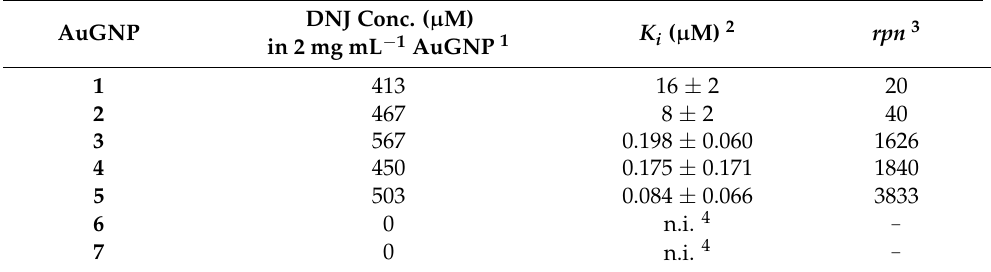
Table 1. Inhibitory activity of AuGNPs 1 – 7 towards Jack bean α -mannosidase (JB α